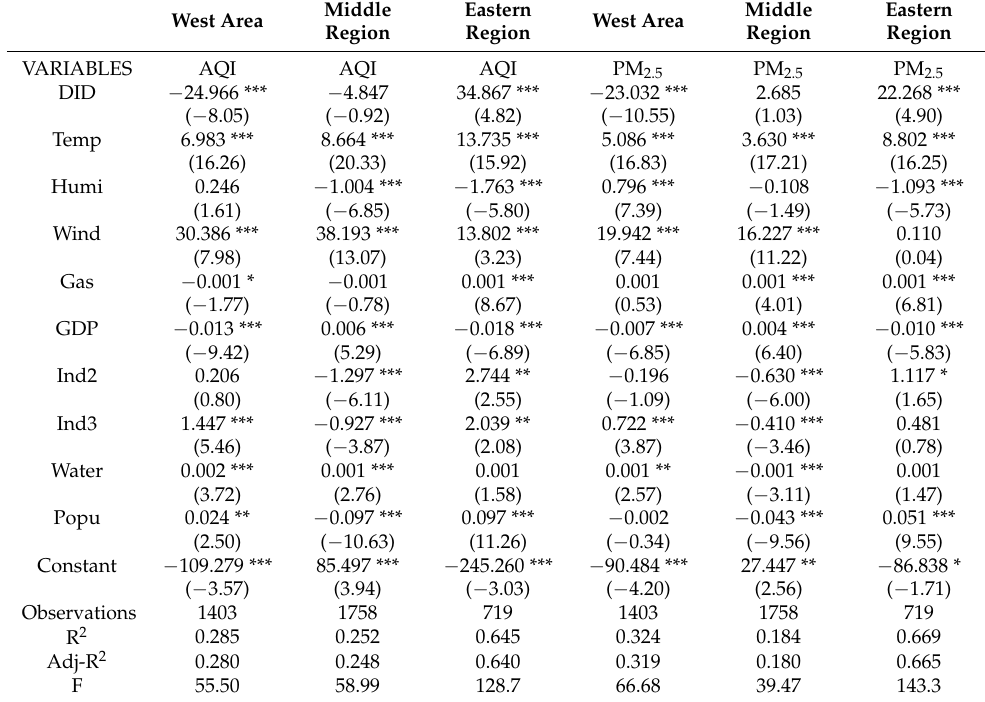
Table 10. Urban heterogeneity test